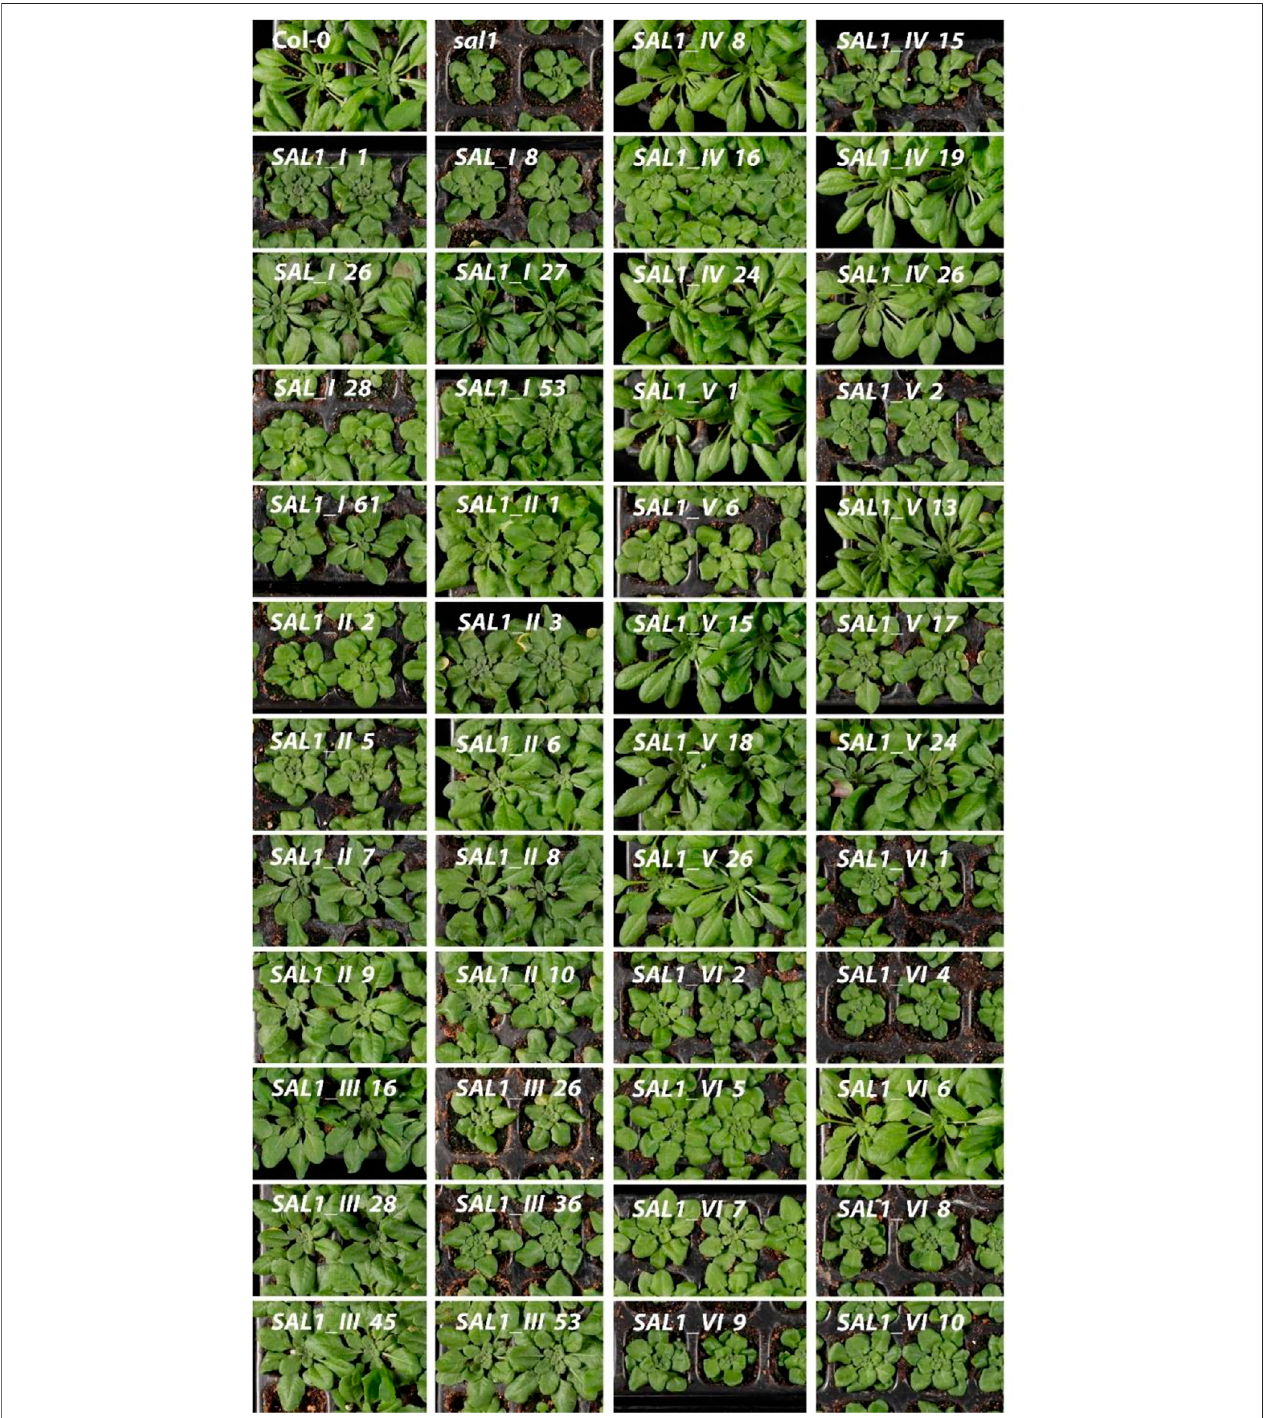
FIGURE 3 | Morphological phenotypes of plants expressing SAL1 chimeric constructs in different cell compartments. Plants were grown for 5 weeks on soil in short days in a controlled environment chamber. Bar (cid:1) 2 cm. SAL1_I , nuclear localization; SAL1_II , cytosolic localization; SAL1_III , chloroplastic localization; SAL1_IV , mitochondrial localization; SAL1_V , chloroplastic and mitochondrial localization; and SAL1_VI , nuclear and cytosolic localization, which served as a positive control for the complementation (Kim and von Arnim, 2009).